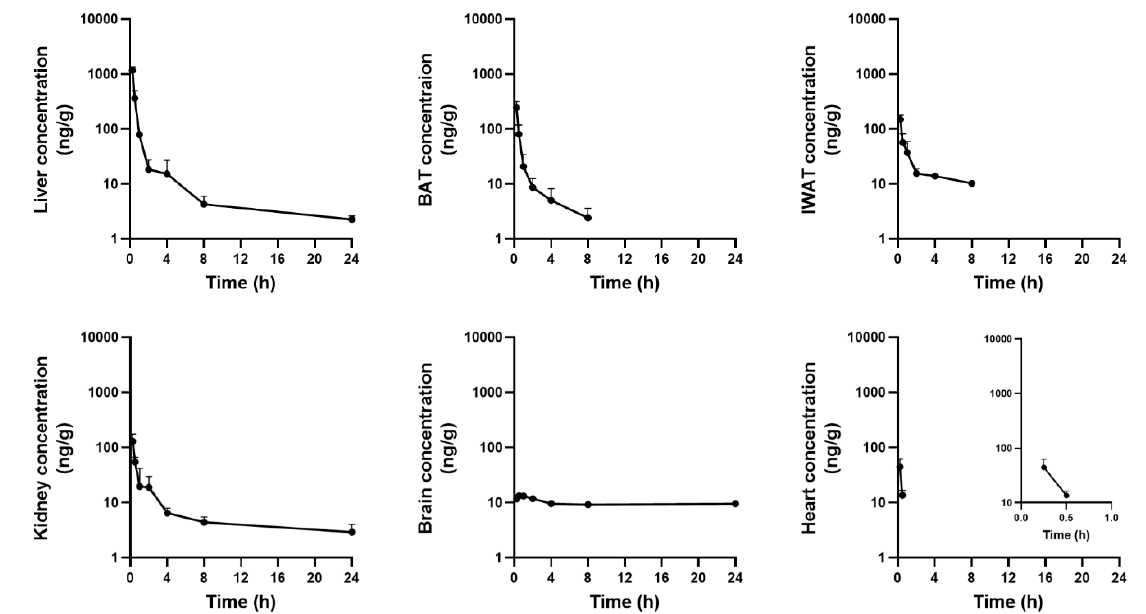
Figure 3. Mean tissue concentration–time curves of 13 C 4 SA in mice after a PO 100 mg/kg dose